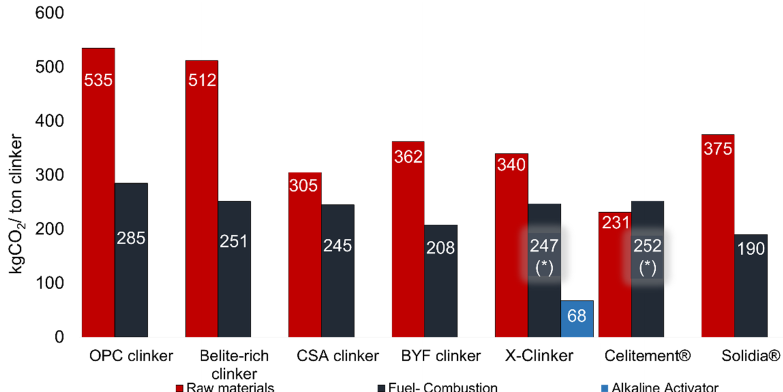
Figure 4. CO 2 contributions for the energy- and material-related emissions of the various alternative binders reviewed. NOTE: (*) indicates the technologies that already consider a fully electrified production process and therefore, depending on the nature of the electricity used, the thermal component of CO 2 emissions can be completely eliminated.